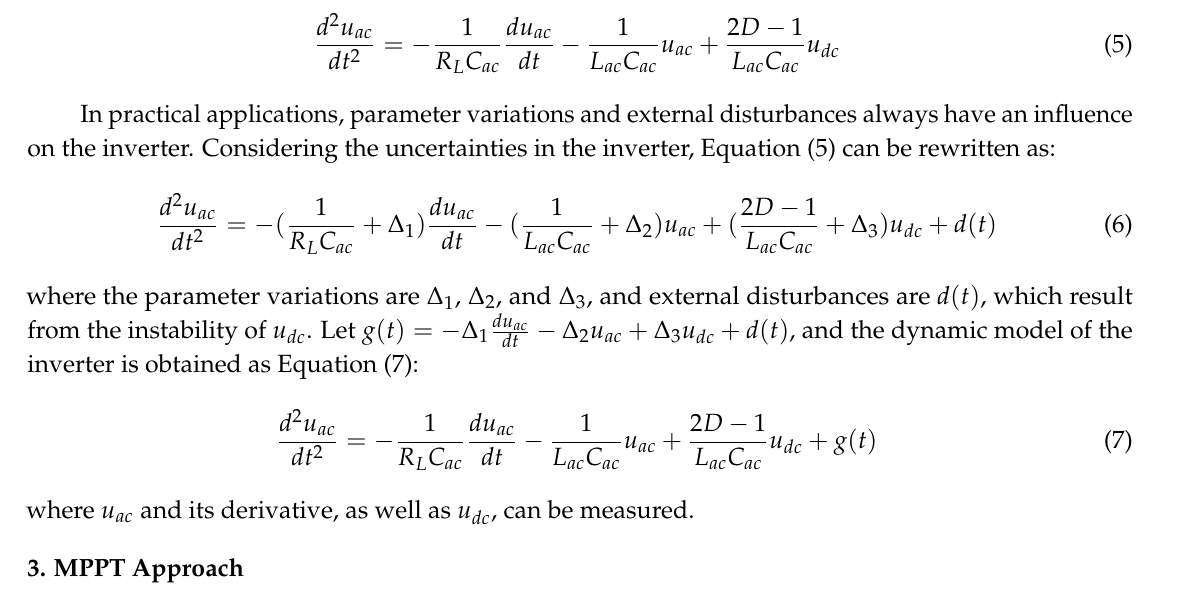
Figure 5. INC with adaptive size. 4. Adaptive Fuzzy Sliding Mode Control A grid-connected PV inverter is used to guarantee that the output voltage of the inverter can follow the grid reference voltage. The block diagram of the AFSMC algorithm is shown in Figure 6. First, an integral sliding surface is selected, then the equivalent (EQ) controller is calculated by setting